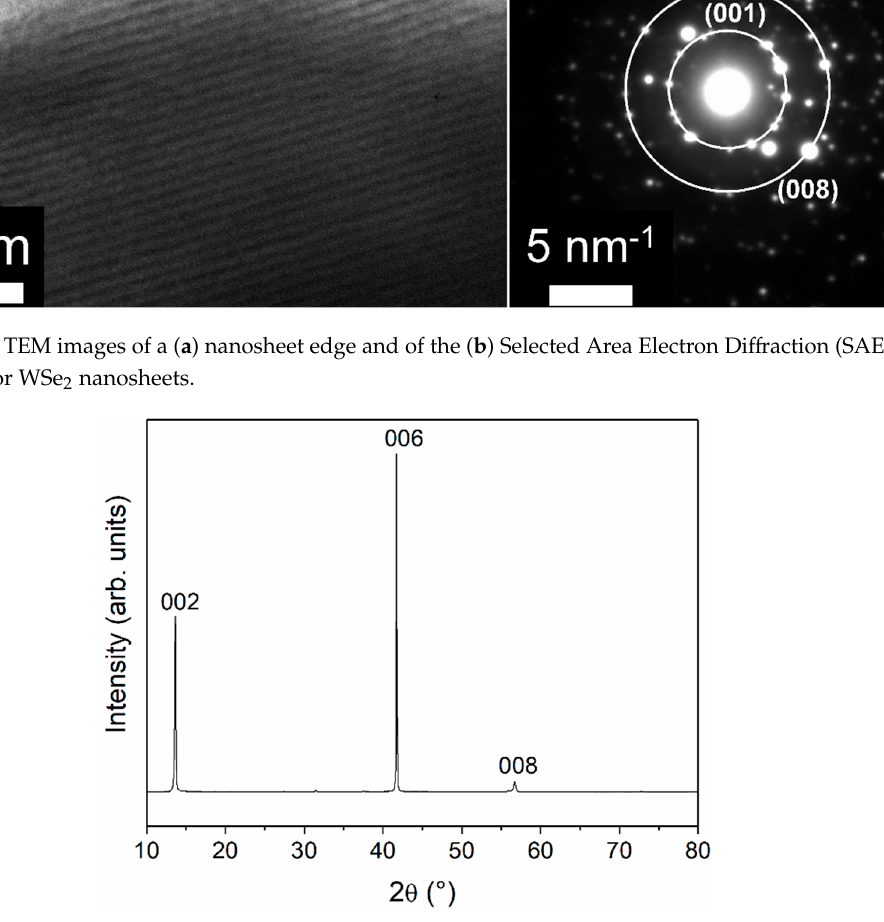
Figure 2. TEM images of a ( a ) nanosheet edge and of the ( b ) Selected Area Electron Diffraction (SAED) pattern for WSe 2 nanosheets.